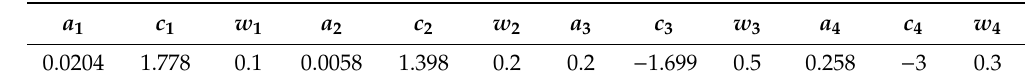
Table 4. The parameters of the PSD of the LX-17.